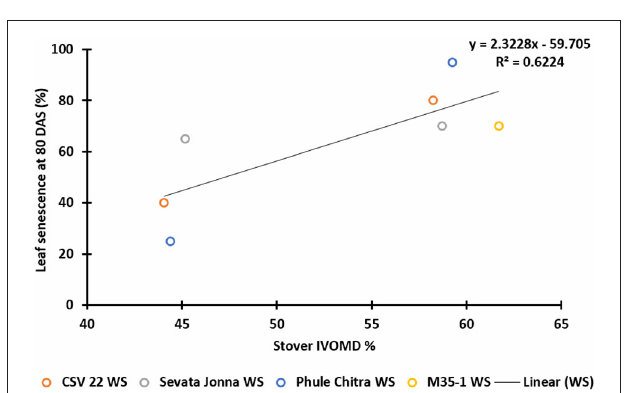
Farmer 1 [F1], male, from Saleguda: “CSV22 and Phule Chitra suit my land. I have saved seeds from the harvest for next